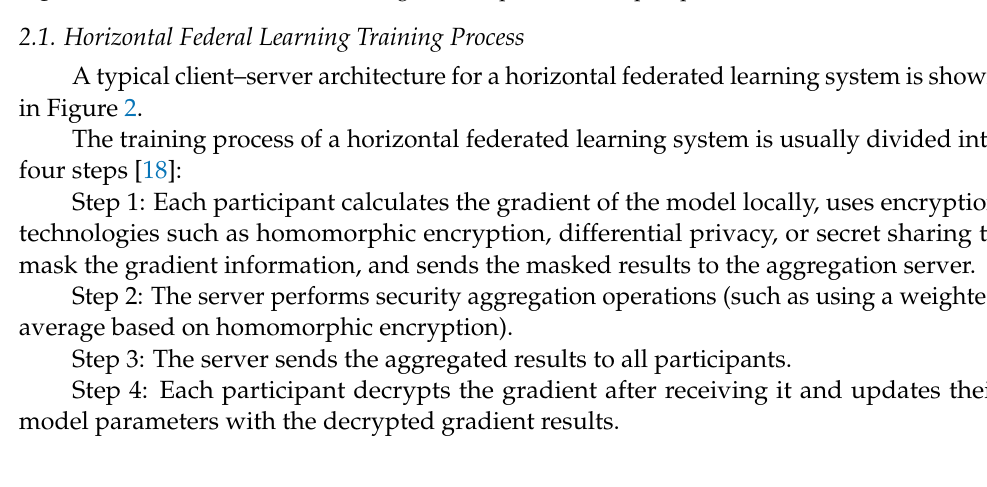
Figure 1. Transverse federated learning feature space and sample space.